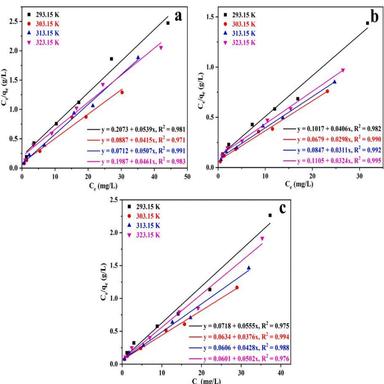
Langmuir adsorption isotherm of TTC onto (a) Ti-TPA-Si, (b) Ti-TPA-Si-C, and (c) Ti-TPA-Si-CS at different temperatures.